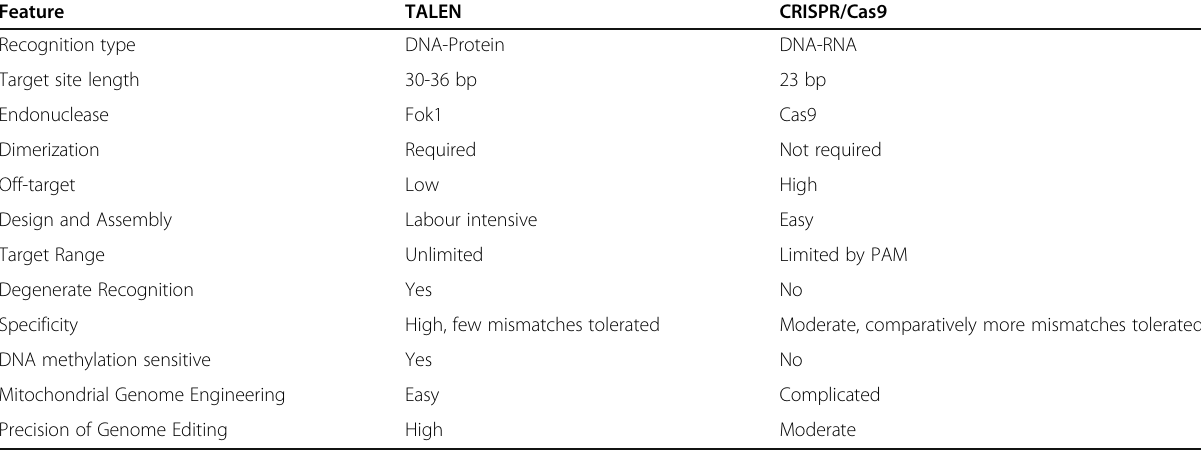
Table 1 Comparison of TALEN and CRISPR/Cas9-mediated genome editing